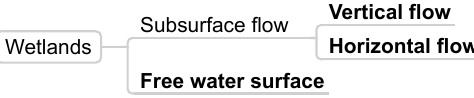
Figure 9. Partial taxonomy: